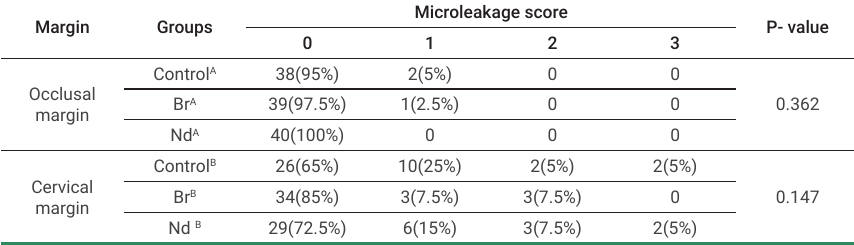
Table 2. Score of microleakage in the study groups